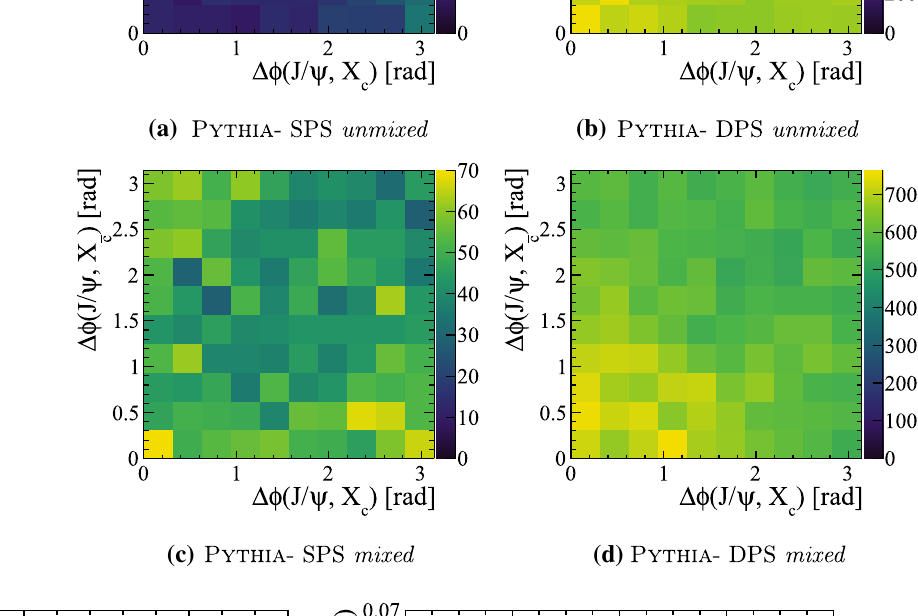
Fig. 21 Relative transverse distributions in J / ψ X c X ¯ c events for SPS and DPS processes in both the mixed and unmixed configurations